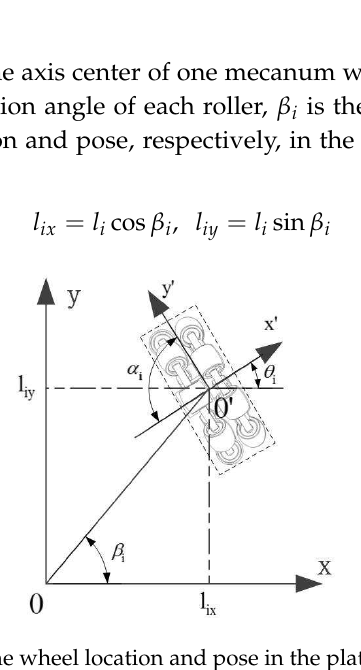
Figure 3. The wheel location and pose in the platform